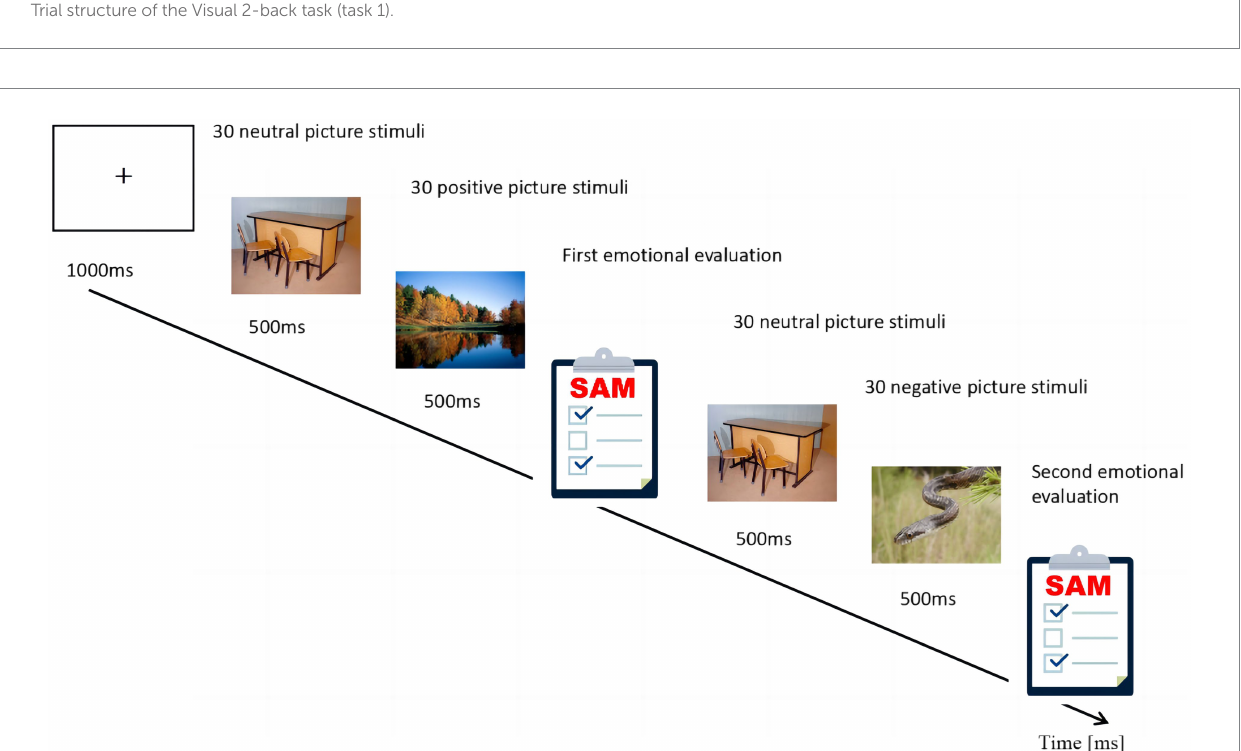
FIGURE 3 Trial structure of the emotion regulation task (Task 2). “Pictures for emotion induction” by The Geneva Affective Picture Database (GAPED) Reproduced with permission from Dan-Glauser and Scherer